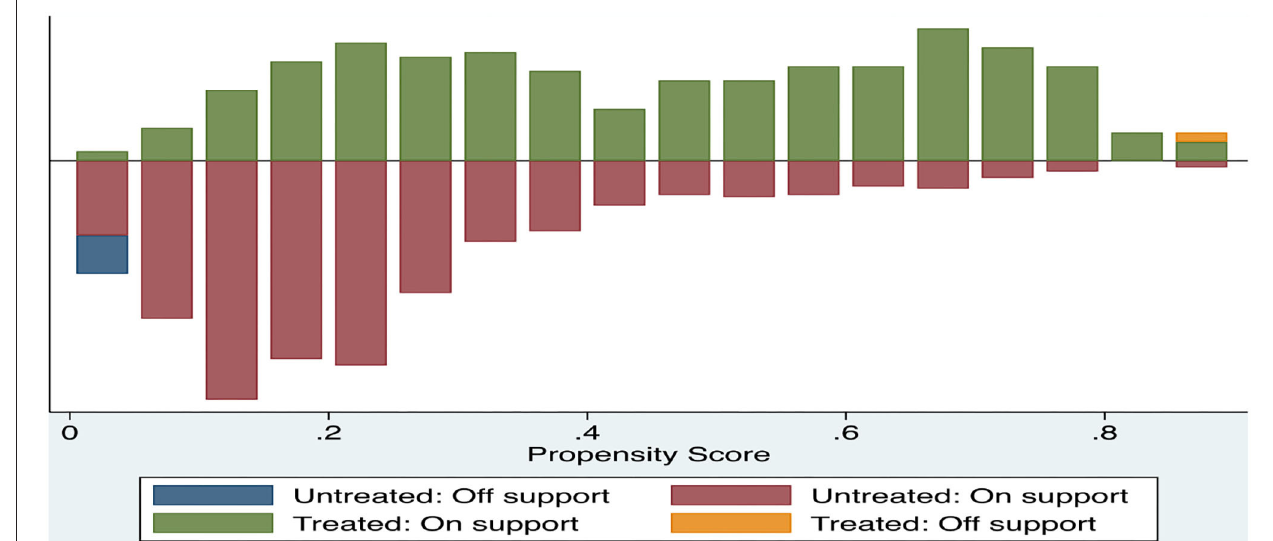
FIGURE 5 | Test of region of common support: value of harvest per acre (NGN/acre).